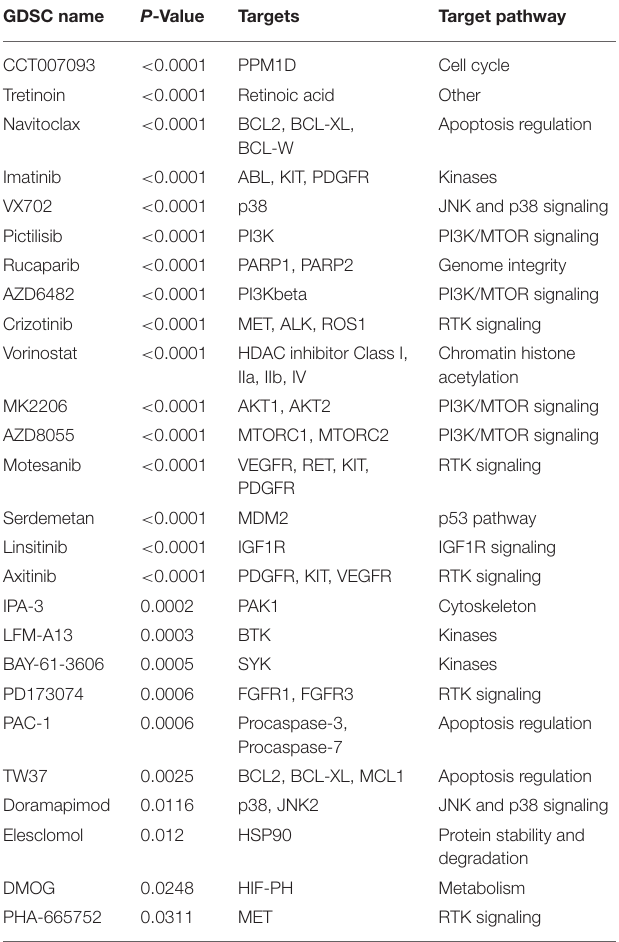
TABLE 1 | Screened drugs with selective sensitivity targeting glycolysis-associated signature. GDSC